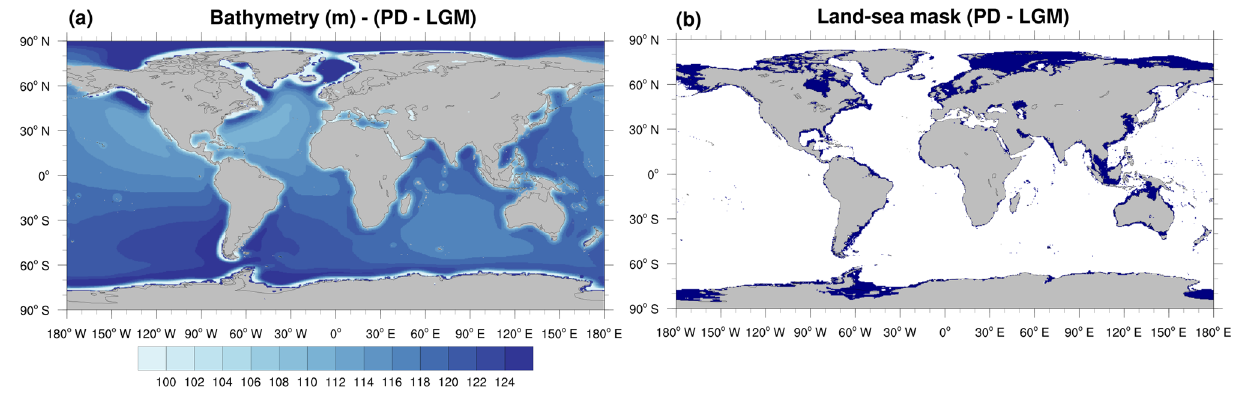
Figure 1. Difference in (a) ocean bottom depth (m) and (b) land-sea mask between present-day conditions (PD) and 21ka (LGM) estimated from the ICE-6G_C ice-sheet reconstructions. Blue in (b) represents ocean area during PD that was land during the